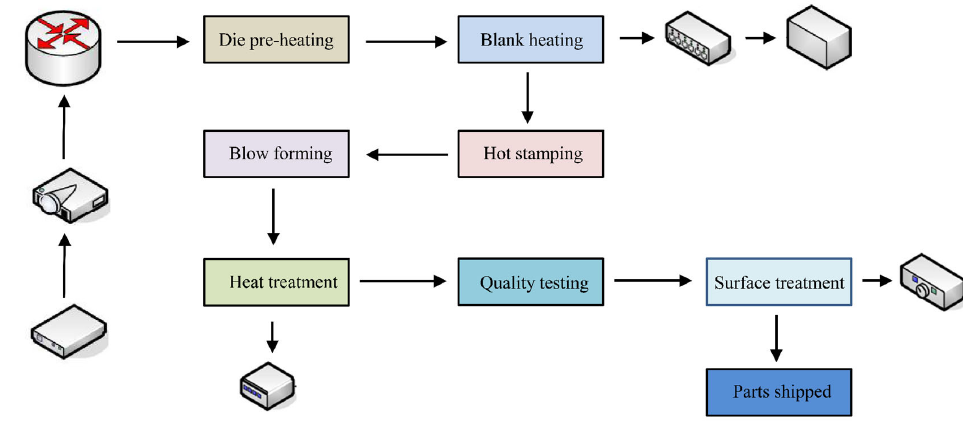
Figure 2. The process of the whole